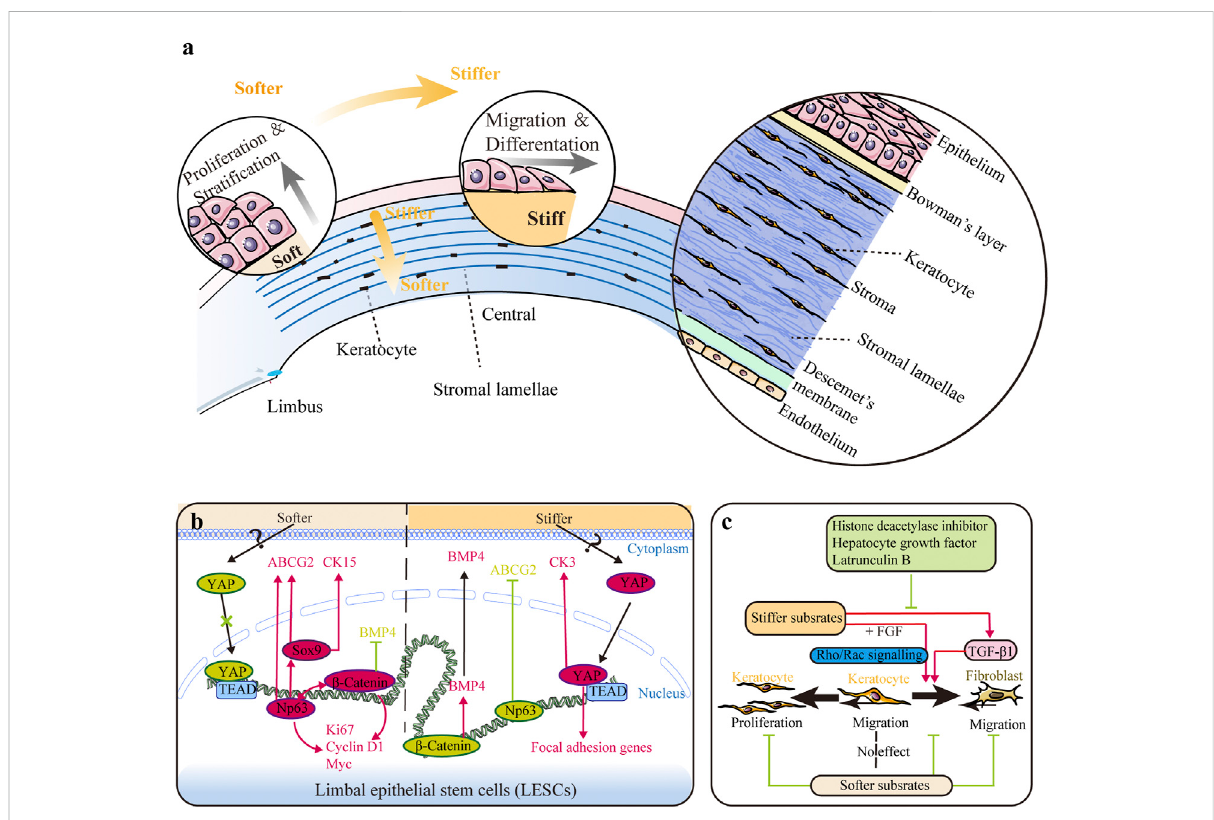
FIGURE 1 Impactofsubstratestiffness. (A) Schematicrepresentationofthemainchangesinsubstratestiffnessandtheireffectsonthecornealepithelium. The central region is stiffer than the peripheral region in both the corneal epithelium and stroma, and the anterior stroma is stiffer than the posterior stroma. Stiffersubstratespromotedifferentiation oflimbalepithelialstemcells (LESCs),while softersubstrates promotetheproliferation process. (B) Substrate stiffness affects the behavior of LESCs via the YAP-dependent mechanotransduction pathway with involvement of Δ Np63 and β - catenin. (C) Substrate stiffness and chemical factors in fl uence the behaviors of keratocytes. Softer substrates inhibit proliferation of keratocytes and migration of fi broblasts. Softer substrates also preserve the phenotype of keratocytes, while stiffer substrate promotes keratocyte – fi broblast – myo fi broblast(KFM)transformationinducedbytransforminggrowthfactor- β 1(TGF- β 1).Thisstiffness-relatedtransformation couldbesuppressed byhistonedeacetylaseinhibitors,hepatocytegrowth factor,andlatrunculinB.Furthermore,extracellularmatrix(ECM)stiffness also affects the response of fi broblasts to fi broblast growth factor (FGF) by the interplay between Rho and Rac